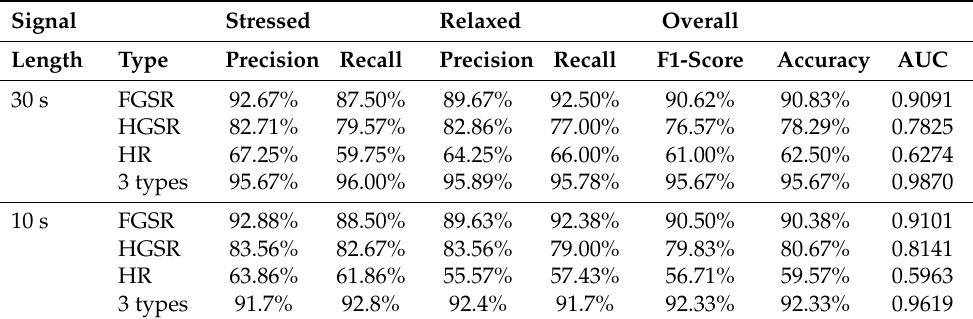
Figure 7. Classification performance in individual recordings based on input signal length (30 s and 10 s). Table 5. Classification performance of proposed method based on input signal length and sensor